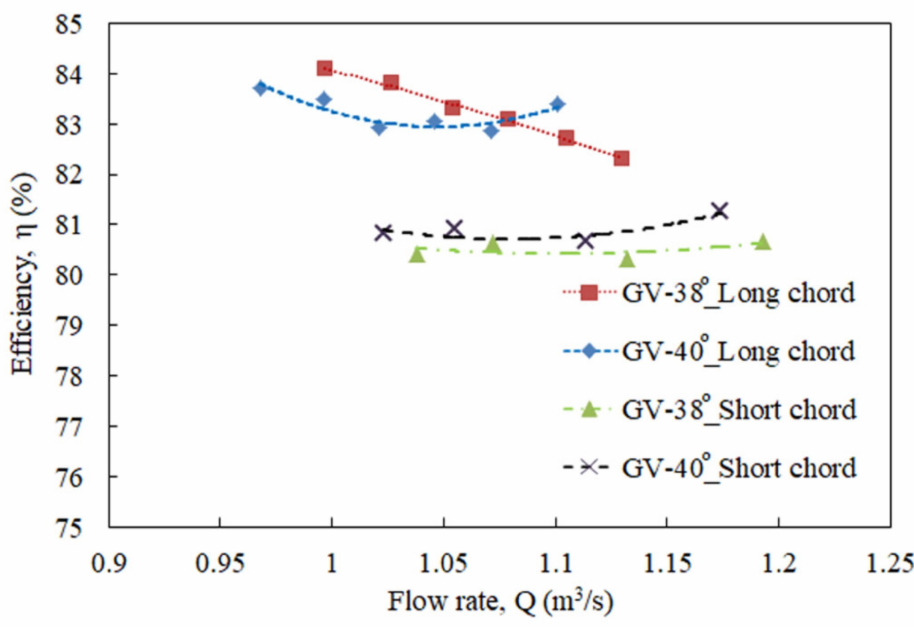
Figure 27. Comparison of efficiency and flow rate according to guide vane opening (RV-19~24 ◦